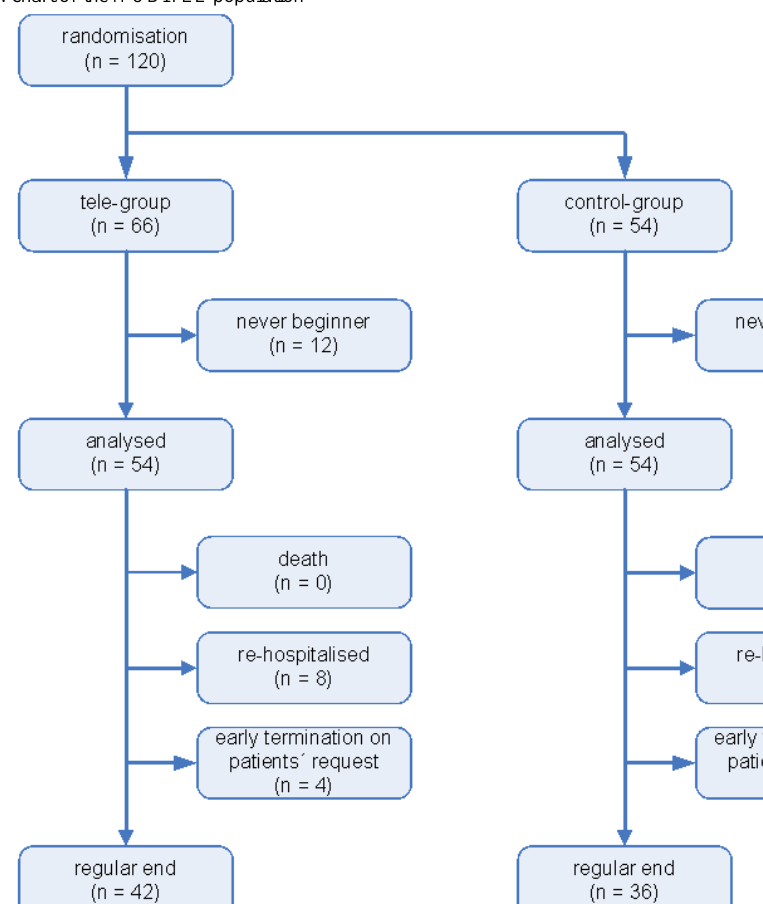
Figure 3. Study flowchart of the MOBITEL